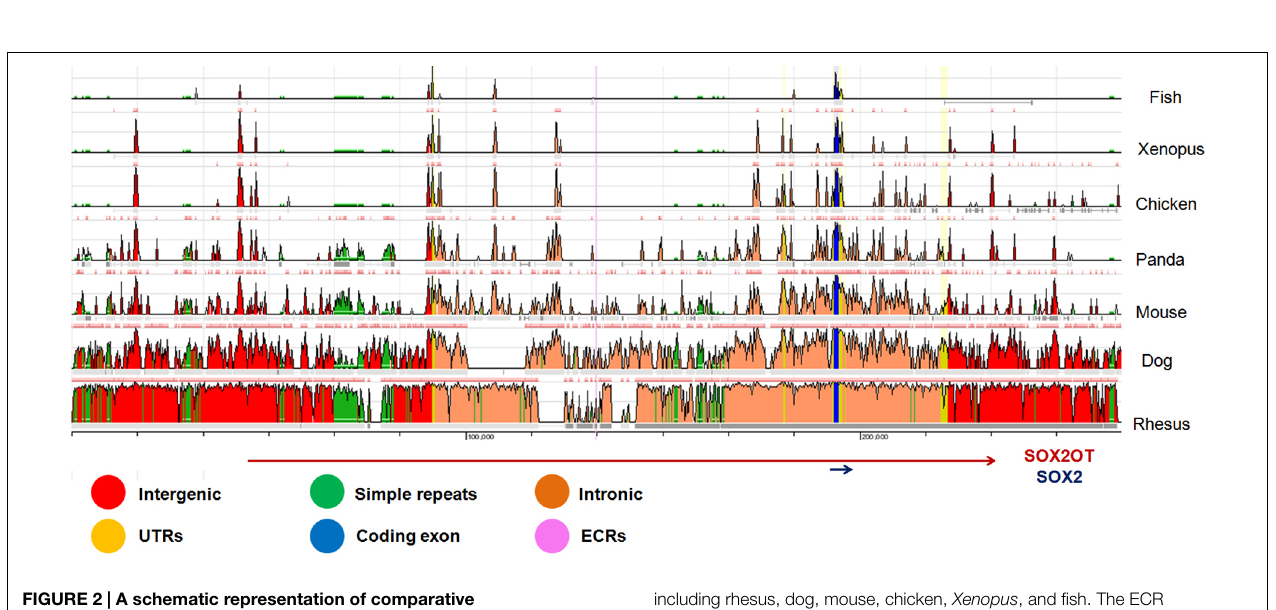
of SOX2DOT. The binding sites distribution for multiple transcription factors of POU domain and HMG-box families is noticeable. (C) A high degree of conservation at upstream of genomic regions of SOX2OT and SOX2DOT in 100 vertebrates is presented, using Multiz alignment program (adopted from http://genome.ucsc.edu).